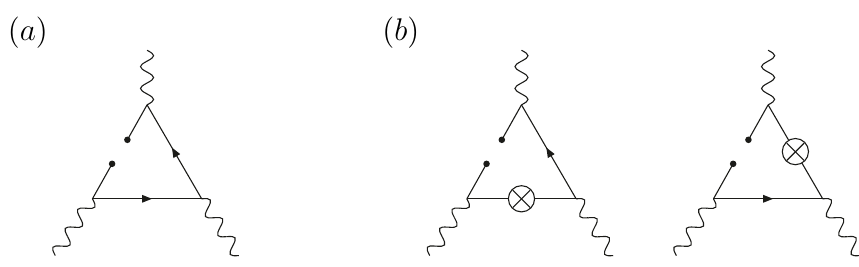
Figure 5 . Diagrams with one cut quark line without gauge boson (a), and with gauge boson (b). The crossed vertices represent a gauge boson insertion on a